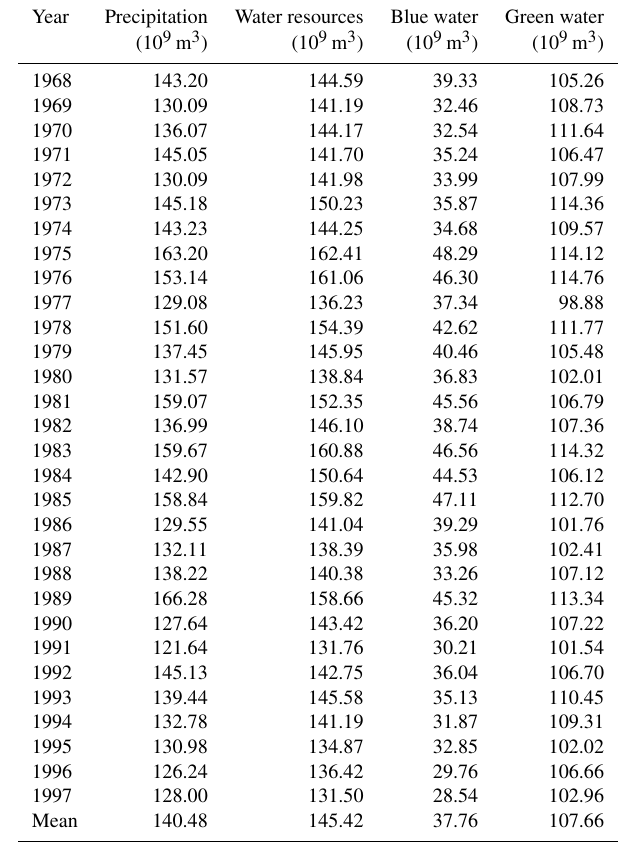
Table 1. The amount of the precipitation and the blue and green water from 1968 to1997